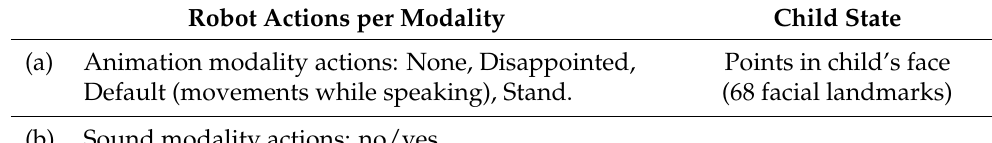
Table 1. A frame with values recorded by NAO robot during a